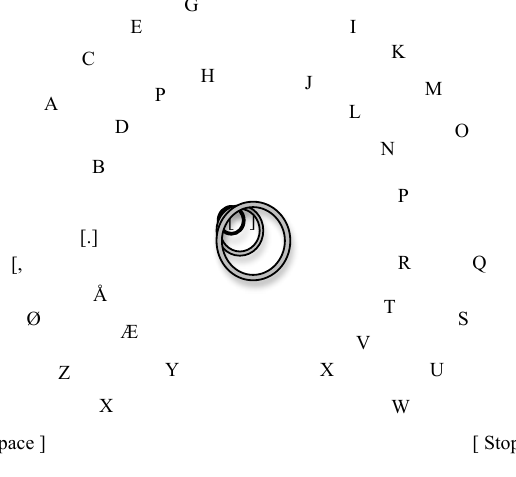
Figure 5: Adapted version of the Stargazer Interface, the cursor indi- cates the direction of gaze. (Hansen et al.,